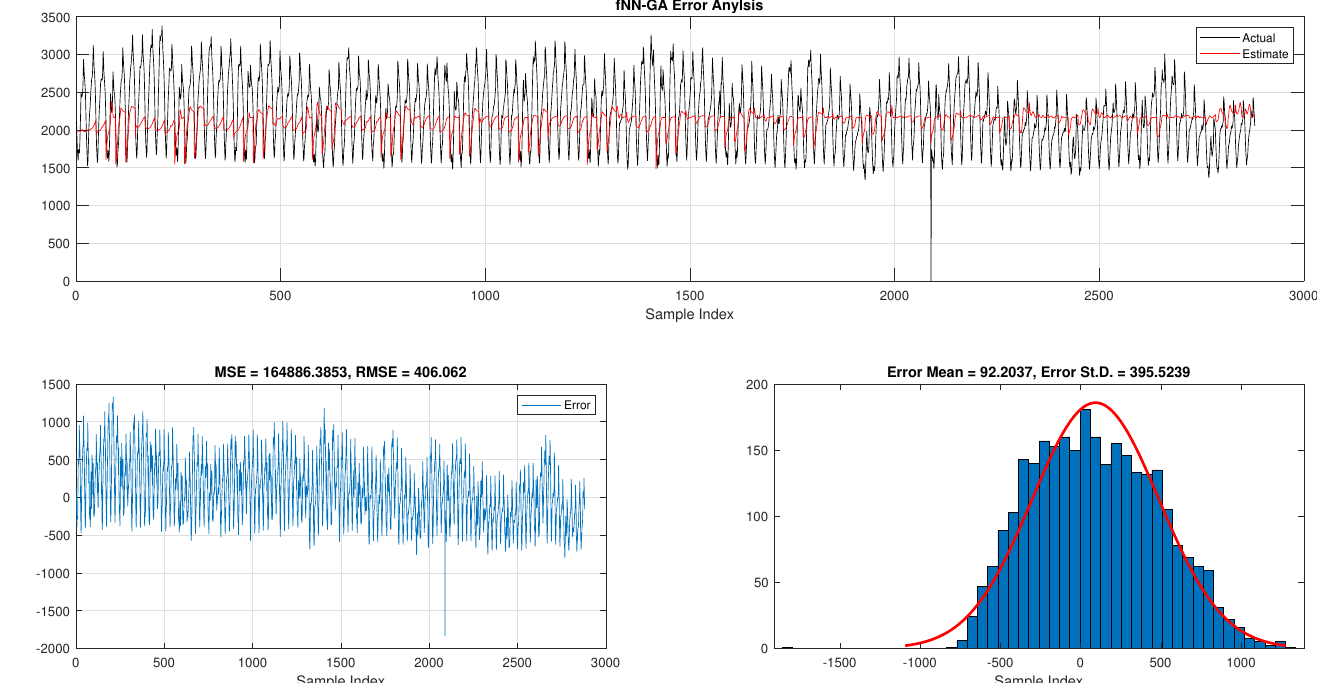
Figure 9. Error analysis of the hourly daily load consumption with fNN-GWO best results.